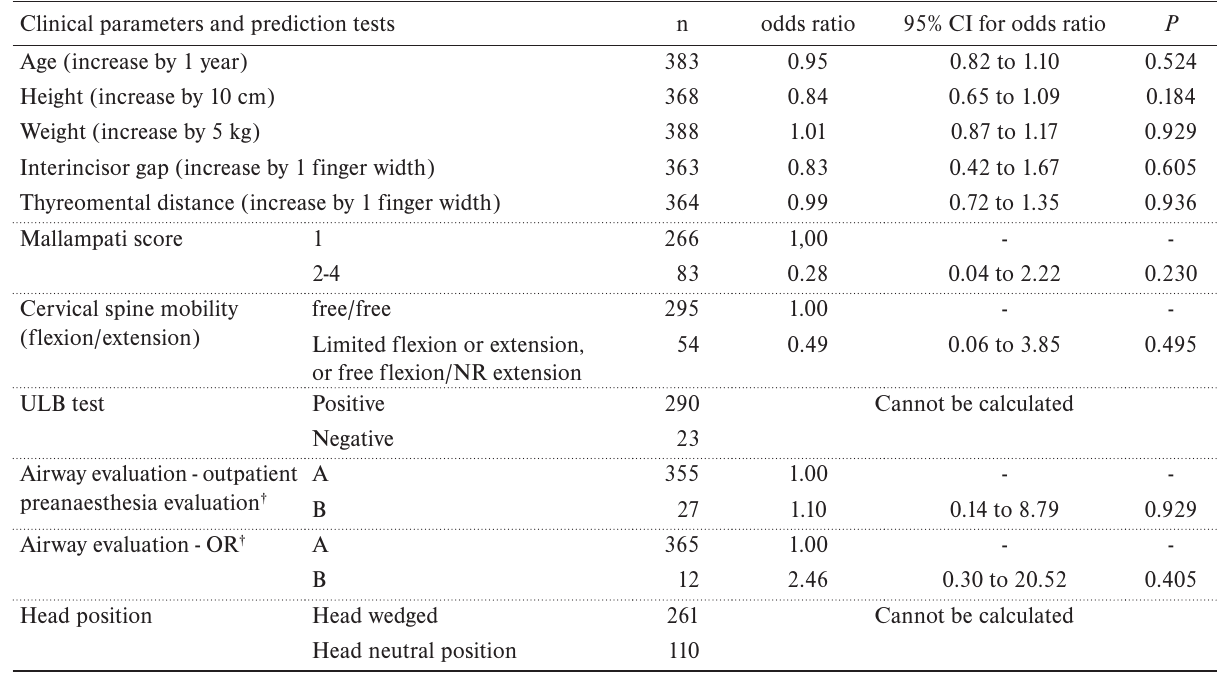
Table 3. Logistic regression analysis for DA prediction and DA